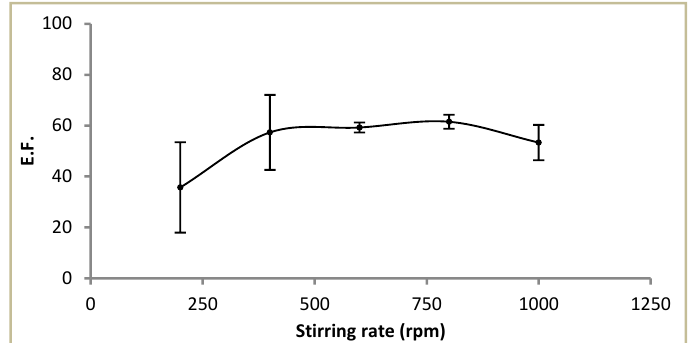
Figure 6. Effect of stirring rate on the enrichment factor. Sample: 0.1 µg L −1 Cd 2+ in NaNO 3 1 M and HEPES 0.1 M. Liquid membrane: Cyanex ® 272 1 M in dihexyl ether. Extraction time: 180 min. Fibre length: 6 cm. Acceptor solution: HNO 3 0.1 M.